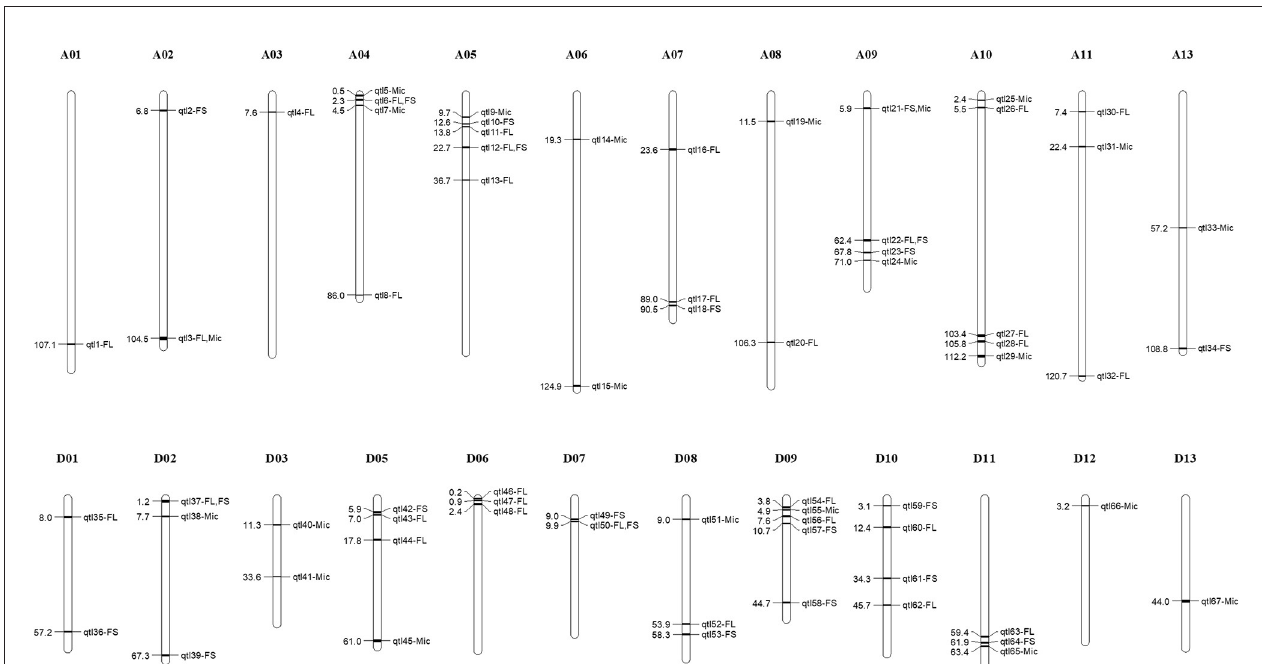
FIGURE 2 | Chromosome distribution of stable quantitative trait loci (QTLs) associated with three fiber quality traits. The numbers on the left of chromosome indicates physical location of the corresponding QTLs. FL, fiber length; FS, fiber strength; Mic, fiber